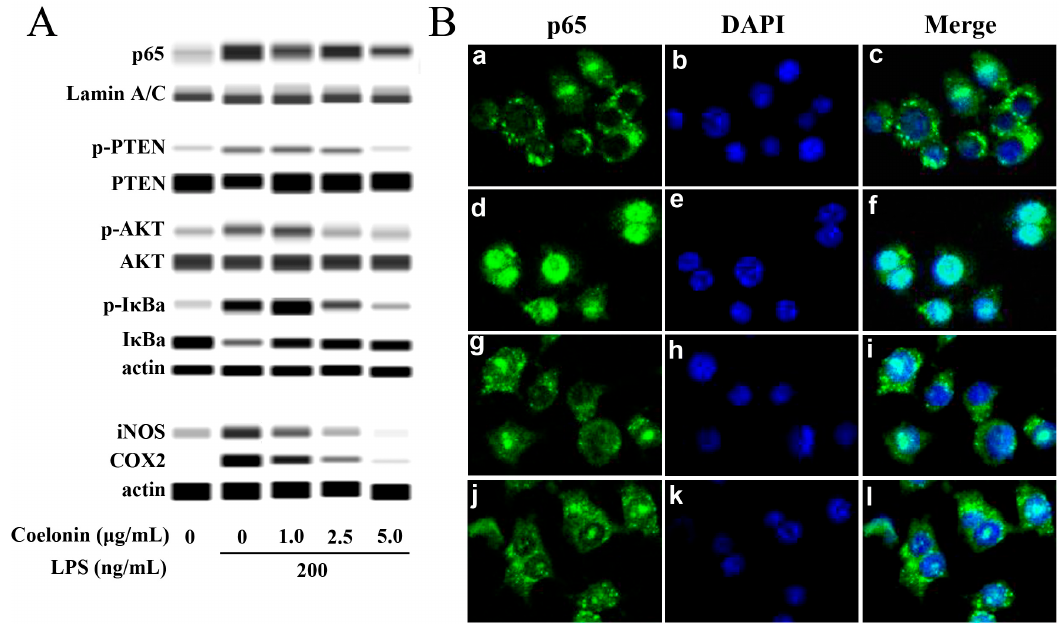
Figure 6. ( A ) Coelonin inhibits LPS induced NF- κ B activation in macrophage. RAW264.7 cells were pretreated with coelonin for 1 h and then treated with 200 ng / mL LPS for 30 min. Then, the nuclear protein was extracted, the content of p65 in the nucleus was determined, the total cellular protein was extracted, and the levels of phosphorylated PTEN, AKT and I κ B α were determined. For iNOS and COX2 detection, RAW264.7 cells were pretreated with coelonin for 1 h, then treated with 200 ng / mL LPS for 24 h, then total cellular protein was extracted and analyzed. ( B ) Confocal microscopy analysis of p65 nucleus translocation. RAW264.7 cells were incubated with solvent (a–c) or 200 ng / mL LPS for 1 h in the absence (d–f) or presence 2 μ M of the NF- κ B inhibitor APDC (g–i) or 5 269 μ g/mL of coelonin (j–l). 270